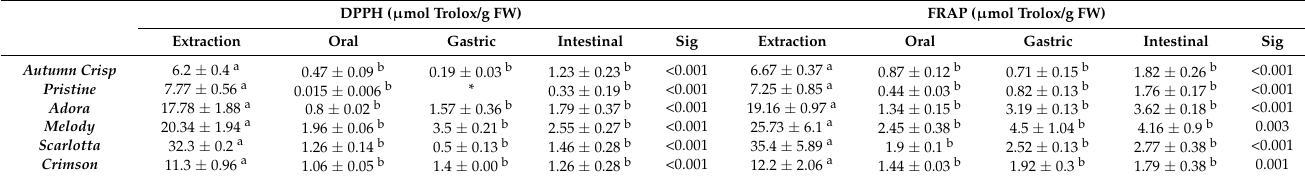
Table 4. Seedless grape antioxidant activity at each stage of digestion.